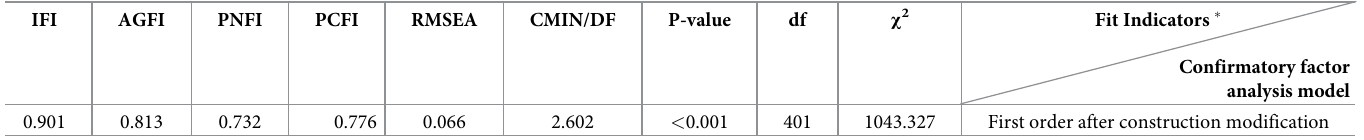
Table 2. Fit indicators of confirmatory factor analysis model of assessment questionnaire of school resilience in emergencies and disasters. IFI